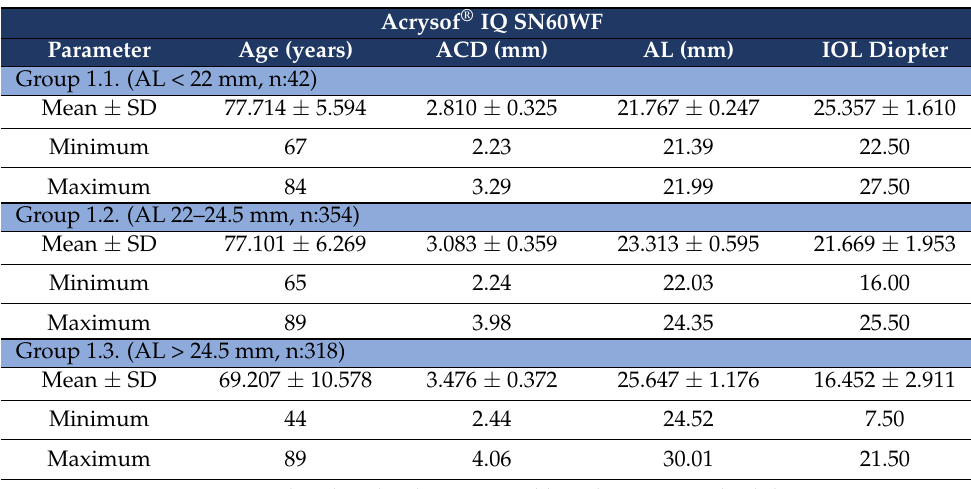
Table 3. Descriptive data of each group with Acrysof ® IQ SN60WF implant.